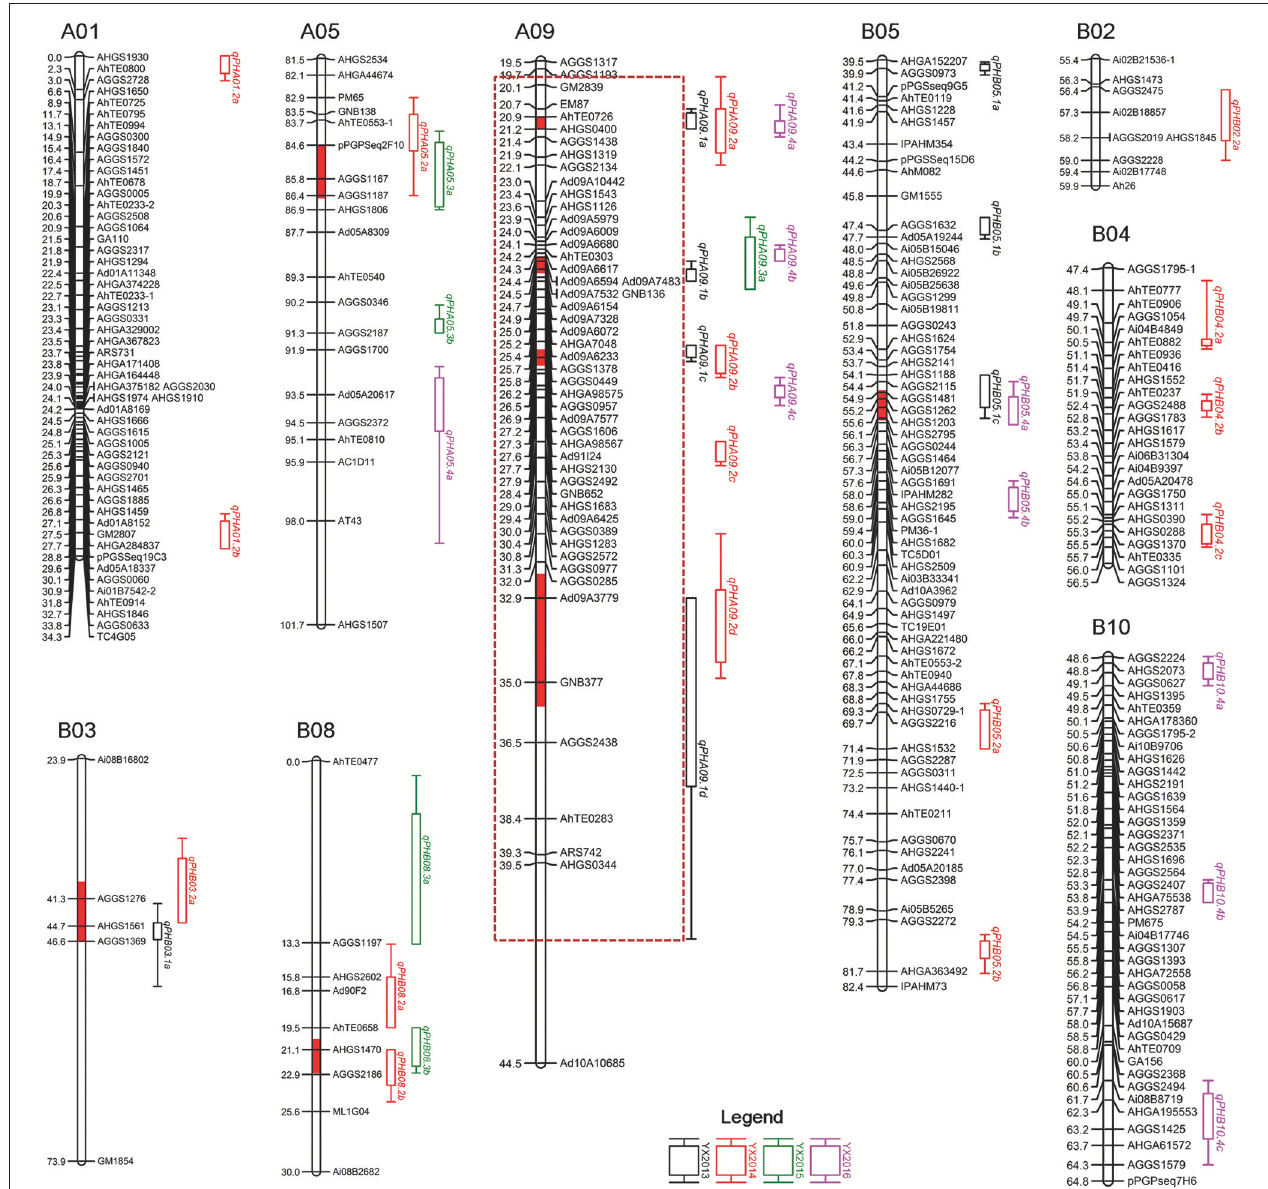
FIGURE 2 | Distribution of QTLs for plant height in the genetic map of the YX population. Consistent QTLs obtained through meta-analysis are highlighted in red color on bars of linkage groups. A dashed box denotes a hot spot QTL region. YX “Yuanza9102 × Xuzhou 68-4” RIL population.